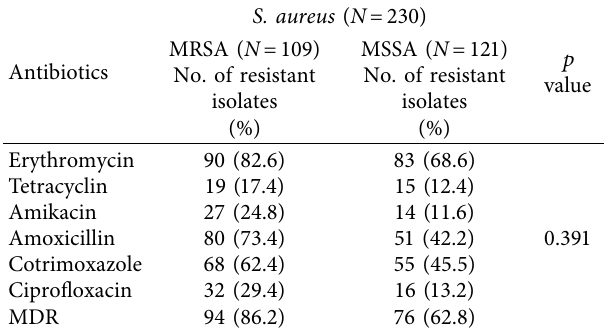
Table 2: Antibiotic resistance between MRSA and MSSA.